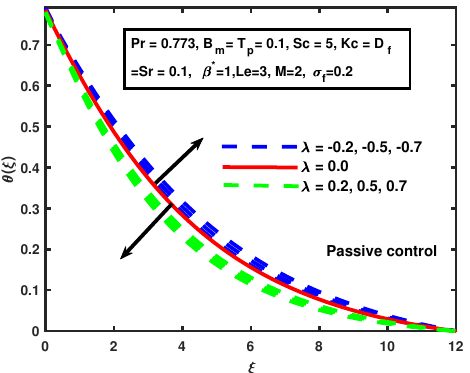
Figure 10. The impact of θ ( ξ ) on suction/injection λ (passive control case).